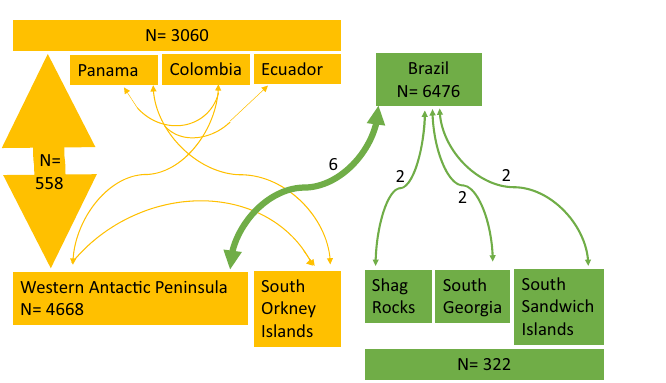
Table 1. Photographic records of individual humpback whales from breeding stock ‘A’ (BSA in green) and breeding stock ‘G’ (BSG in orange). Credit is given for images used, with permission, when not owned by the authors and their institutions. ‘Δt’ is the shortest time interval (in years and months) between migratory destinations.